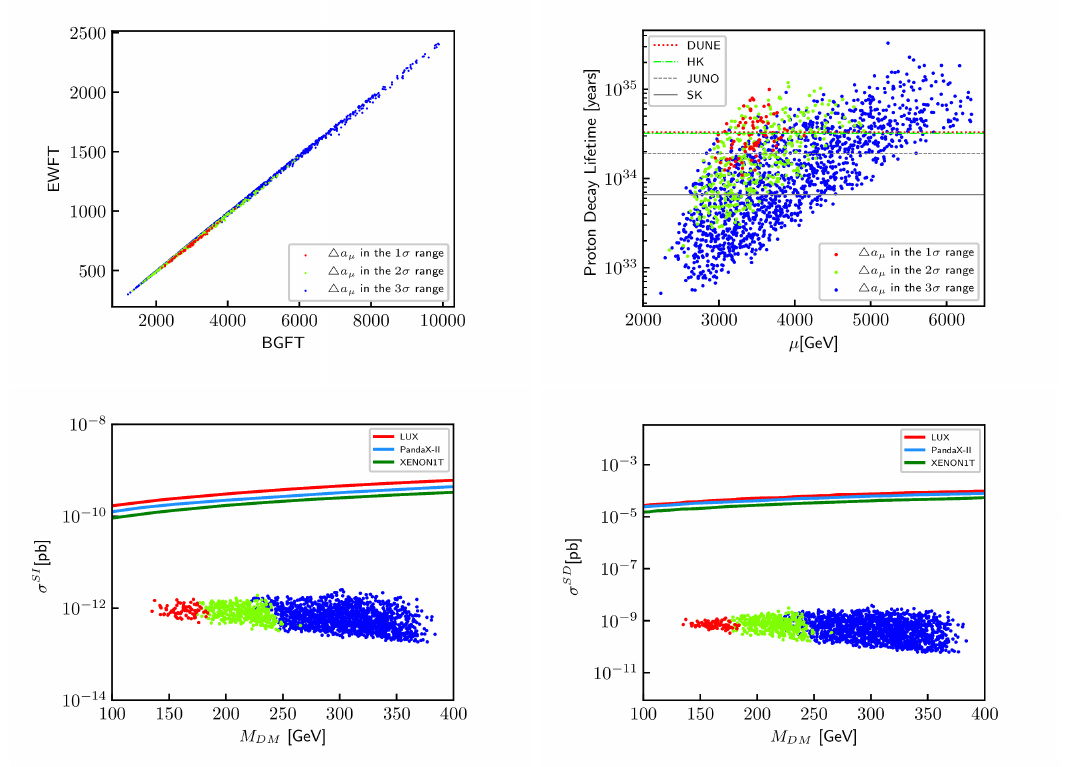
Figure 3 . In the upper left panel, the FTs of the survived points for scenario (1) with the corre- sponding range of SUSY contributions to ∆ a are shown. The proton decay lifetimes via dimension- µ five operators for the survived points are shown in the upper right panel. Possible proton decay bounds by existing super-Kamiokande, the forthcoming JUNO, DUNE and Hyper-Kamiokande ex- periments are also shown. The SI (left) and SD (right) direct detection cross sections with bino dark matter are shown in the lower panels. The red, green and blue points denote the survived samples that can give ∆ a SUSY above the 1 σ , 2 σ and 3 σ bounds, respectively. The exclusion limits µ for DM direct detection from LUX [156], XENON1T [157, 158] and PandaX [159] are also